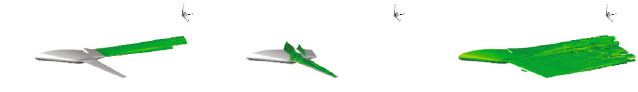
Figure 12: Jet region, shock region, and shear layer region.